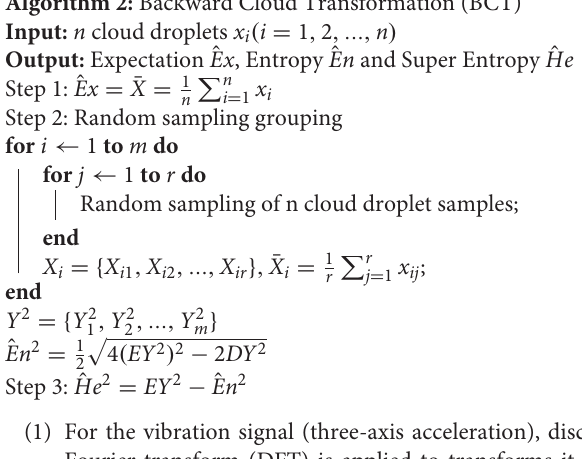
Algorithm 2: Backward Cloud Transformation